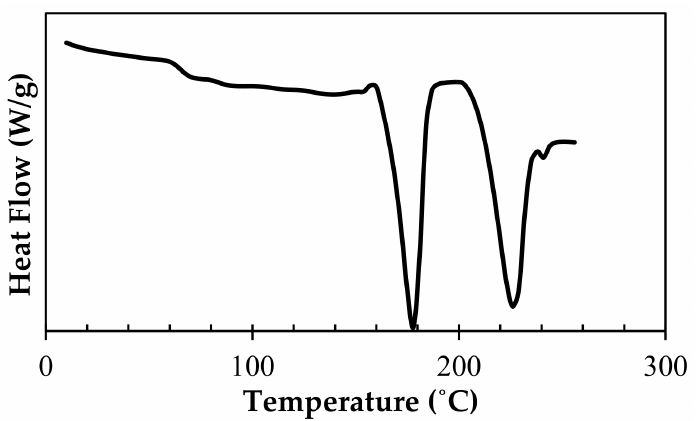
Figure 2. The first DSC thermogram of pellets comprising 50% stereocomplex crystallites/50% PLA homocrystallites based on the melting enthalpy